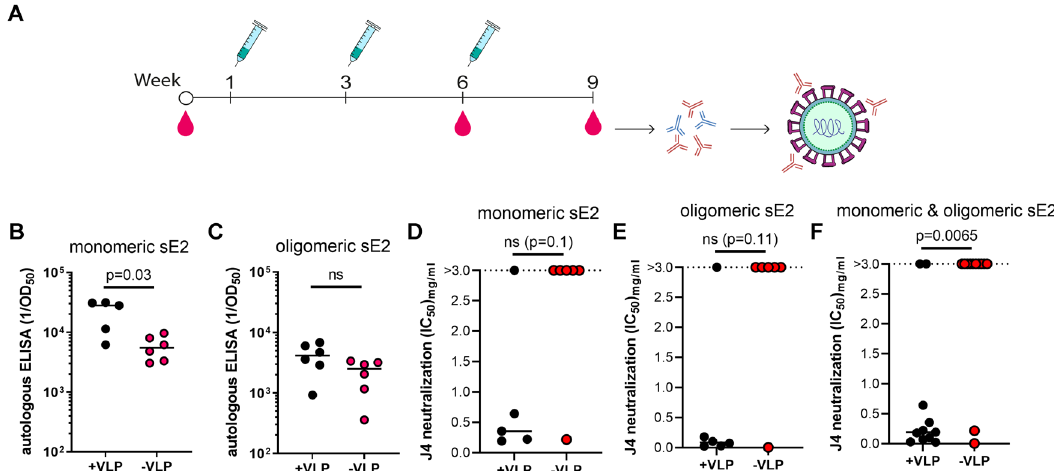
Fig. 2 AP205 cVLPs boosts the induction of HCV speci fi c IgG in immunized mice. A A schematic illustrating the immunization schedule and serum collection from BALB/c mice. Dose-response ELISAs against either monomeric ( B ) or oligomeric ( C ) sE2 of week 9 mouse serum samples collected from animals immunized either with ( B ) monomeric or ( C ) oligomeric sE2 alone or on cVLPs. ELISAs were done in single replicates using anti-mouse IgG coupled to HRP and subsequently a colorimetric TMB substrate signal was detected. Binding results were assessed by four parameter curve fi tting to calculate OD 50 values. Data is represented with median value of inverse OD 50 values of puri fi ed IgG from individual animals. D , E Dose-response neutralization of HCV recombinant J4 (genotype 1b) HCVcc was done in three replicates using mouse IgG and was evaluated in FFU reduction assays on Huh7.5 cells. Following 48 h of infection the cells were fi xed and FFUs were visualized using HCV anti-NS5A antibody followed by anti-mouse antibody coupled to HRP followed by DAB staining of FFUs. Results were normalized to non- infected control cells and neutralization was assessed by four parameter curve fi tting to calculate IC 50 values. If 50% neutralization was not reached at the highest tested dose then IC 50 values were interpolated if neutralization at highest dose reached a minimum of 30% and increased to at least 50% at 3 mg/ml. Data is represented with median value of inverse IC 50 values of puri fi ed IgG from individual animals. F The IC 50 values from panels D and E were pooled into groups where antigen was either coupled to VLPs or not. Statistical signi fi cance testing was done using non-parametric Mann-Whitney tests (Graphpad Prism 9.2.0) and the signi fi cance threshold was set at